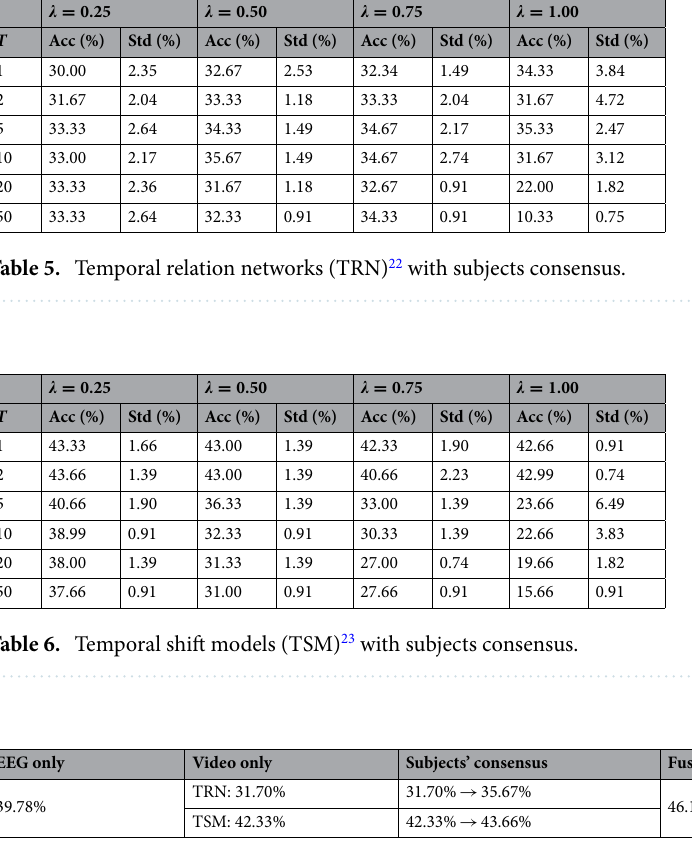
Table 7. Highlights of the best achieved performance across all data modalities. Subjects’ consensus refers to VIDEO only performance, where models are trained with the additional supervision provided by